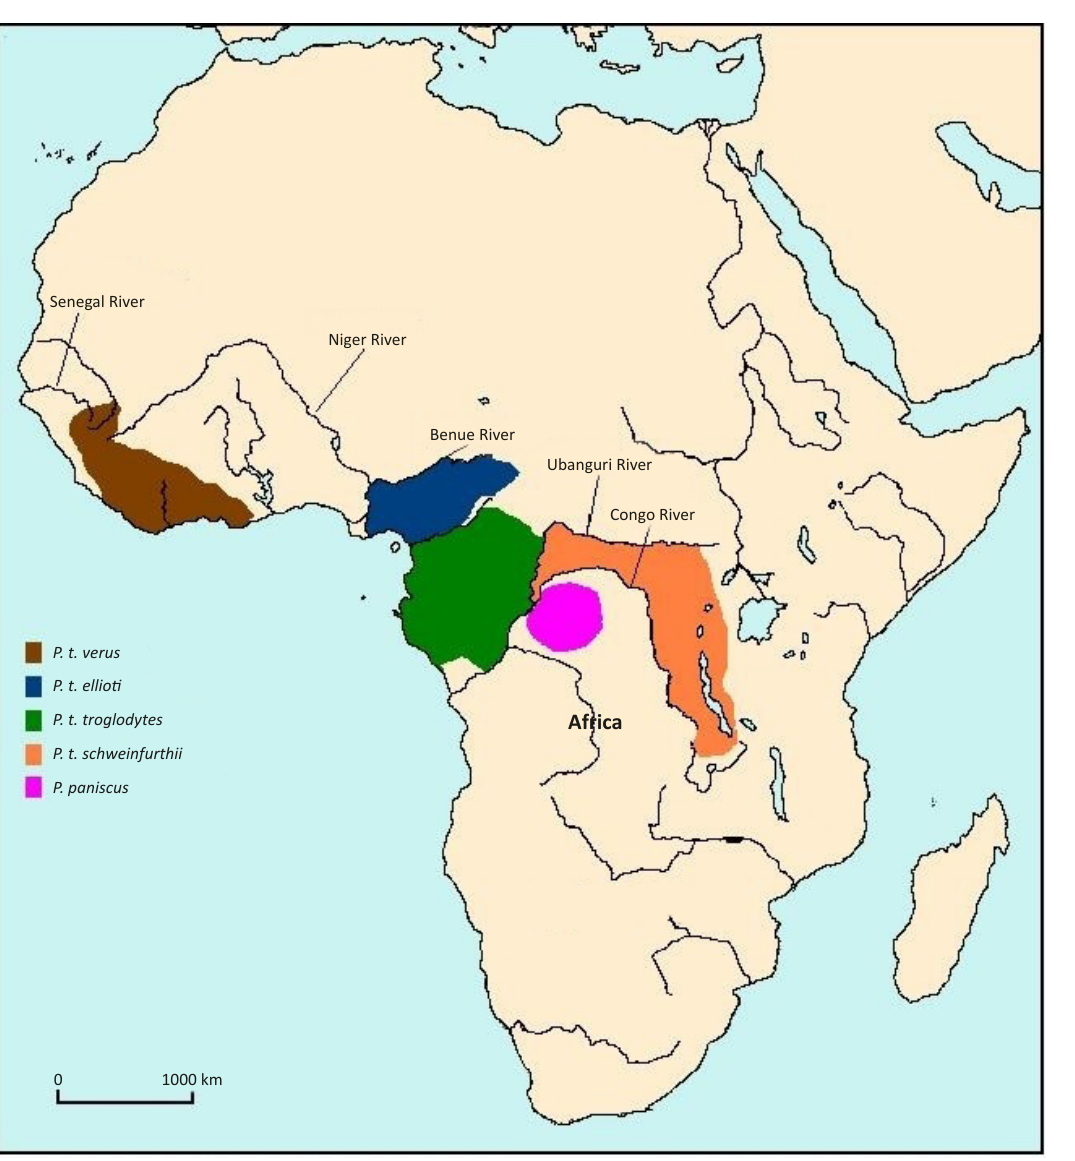
Figure 1. Geographical distribution of different subspecies of Pan troglodytes and Pan paniscus in Africa. Geographical distribution location of the four subspecies of Chimpanzee and Pan Paniscus , represented with a different color in the